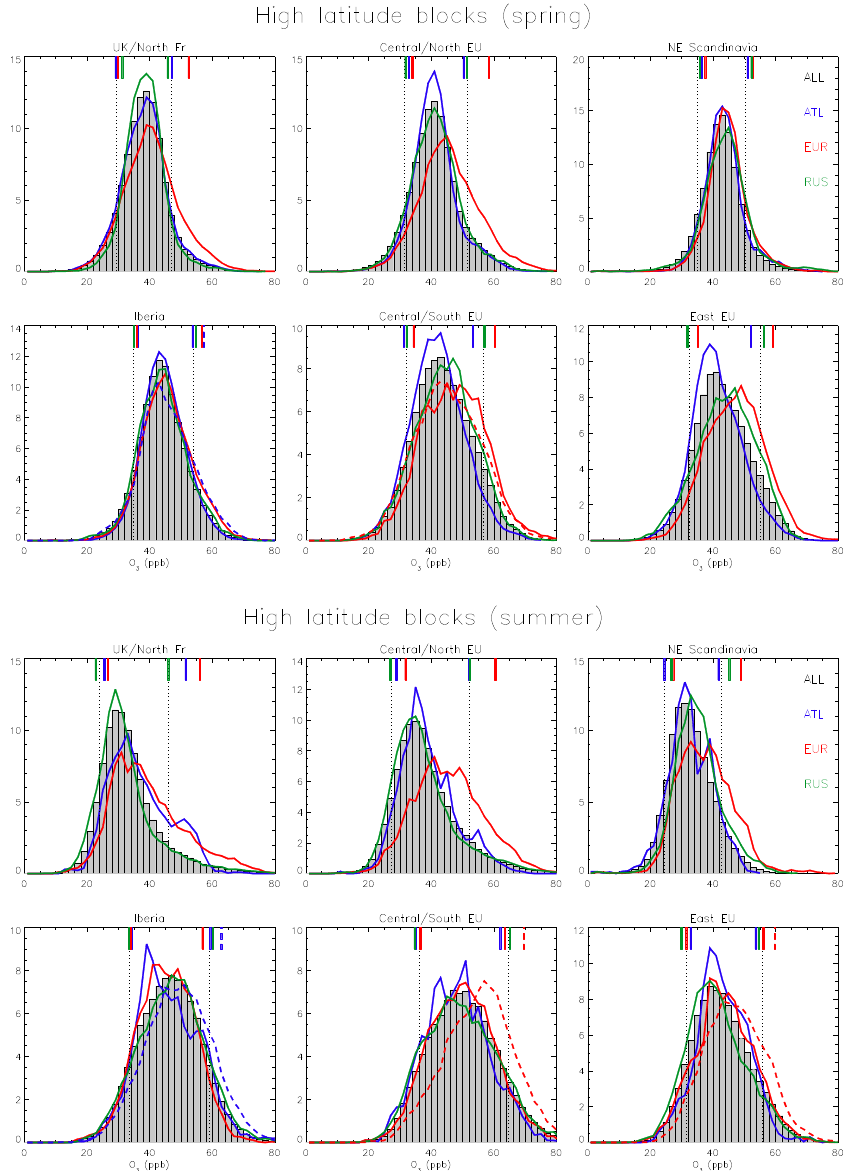
Figure 5. Spring (upper panels) and summer (lower panels) probability frequency distributions (%) of MDA8 O 3 for the six regional boxes presented in Fig. 2 under different synoptic situations. Grey bars denote the 1998–2012 seasonal climatology. Solid lines correspond to days with block centres over the Atlantic (blue), European (red) and Russian (green) sectors. Blue and red dashed lines also represent the frequency distributions of the data when ridge centres are located over the ATL and EUR sectors, respectively; they are only shown for the regions and seasons where surface ozone presents the strongest responses to ridges. The width of the bins is 2ppb. The horizontal position of the vertical dotted lines represents the 10th and 90th percentiles of the climatology, while the short vertical lines on the top of the plots indicate the values of the 10th and 90th percentiles under the influence of ATL, EUR and RUS blocking. The 90th percentiles of the data with ridges are also displayed as dashed lines when they are above those with